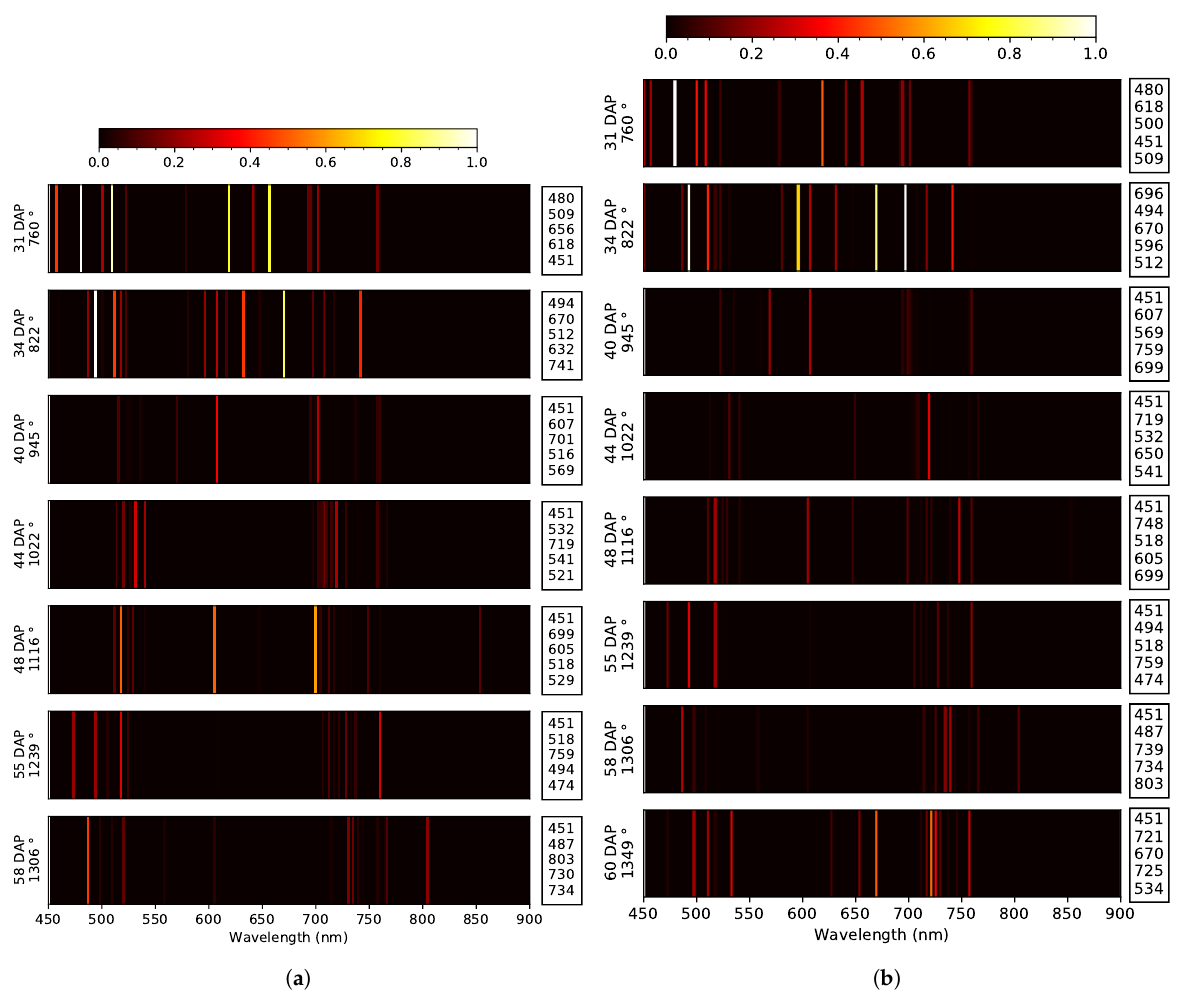
Figure 20. The snap bean 2020 seed length average rankings across for SAM models at ( a ) the early and ( b ) the late harvest stages. The corresponding days after planting (DAP) and heat unit for the collected data are shown to the left of each ranking belt, while the top five features, with the first one having the highest score, are listed to the